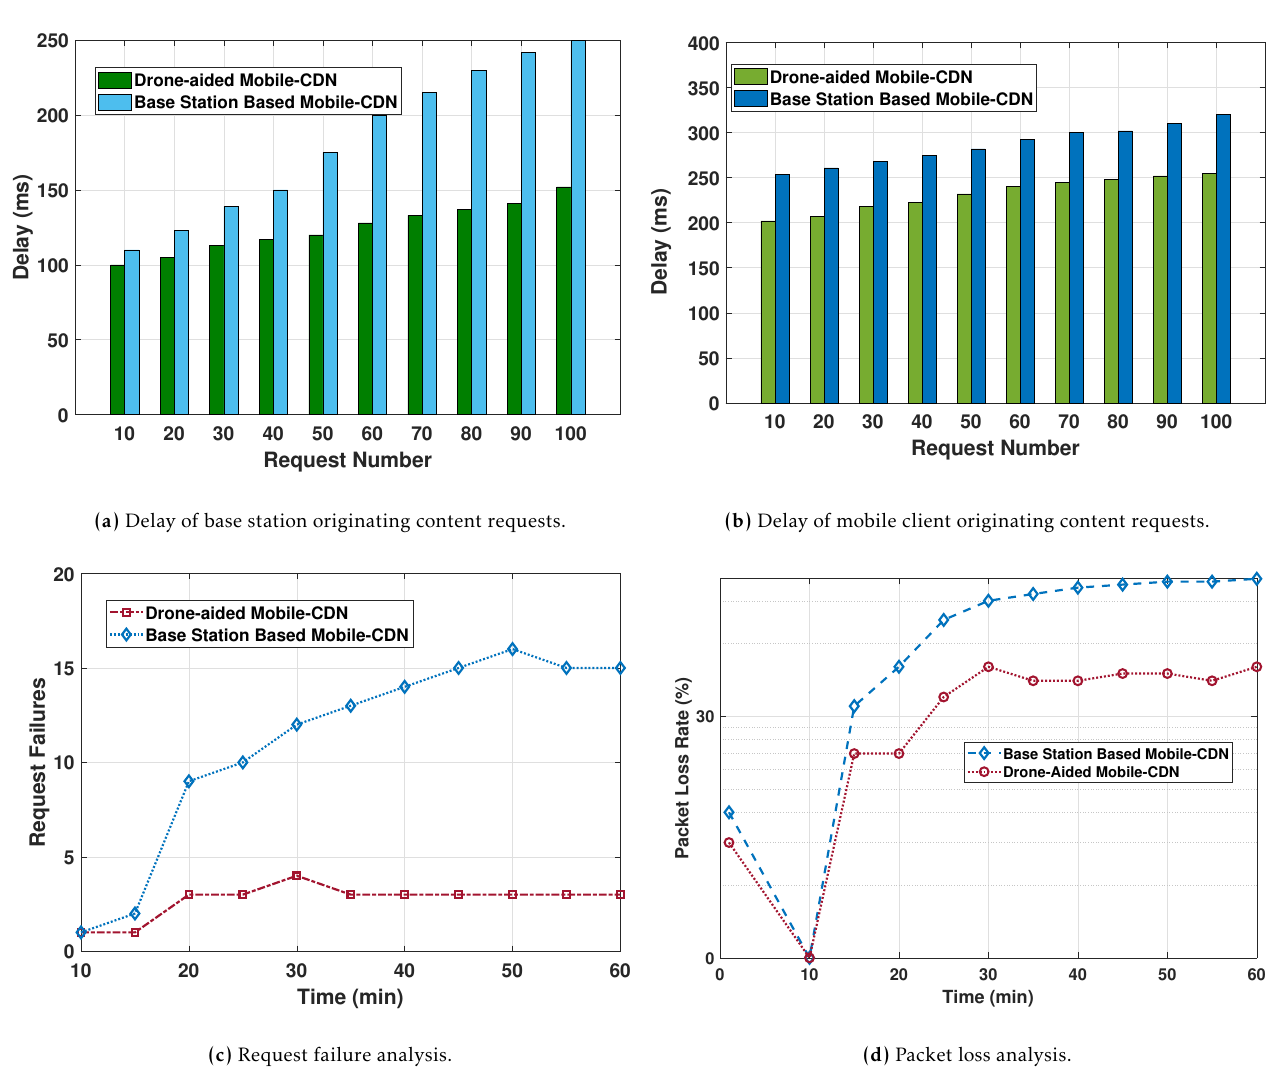
Figure 4. Performance Evaluation